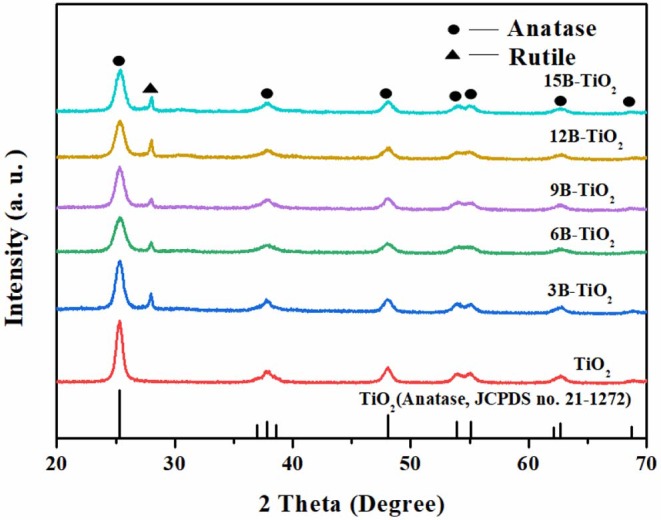
XRD spectrum of B-TiO2 and bare TiO2.